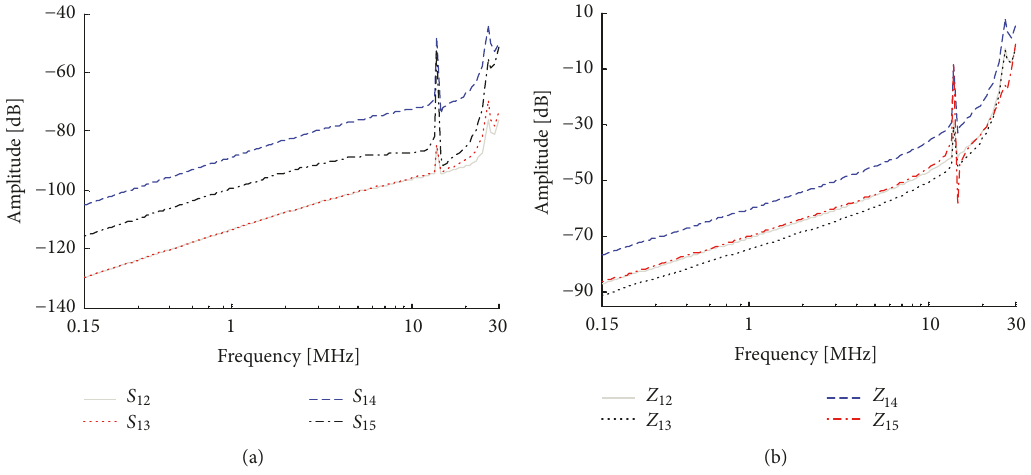
Figure 5: Network parameters: (a) S -parameter; (b) Z -parameter.